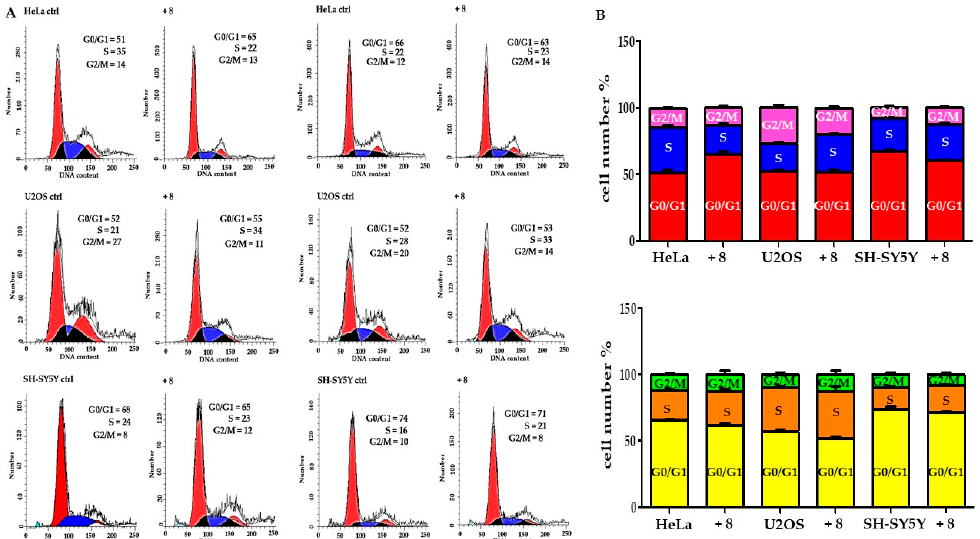
Figure 6. Cell cycle analysis. ( A ). Representative data showed cell cycle distribution with PI staining followed by flow cytometry analysis of HeLa, U2OS and SH-SY5Y cells treated whit 8 (5 μ M) for 24 (sx) or 48 h (dx). ( B ). Histograms show the G1, S and G2/M phase distribution of HeLa, U2OS and SH-SY5Y cells from three separate experimental analyzes, after 24 h (above) and 48 h (below) of treatment. Error bars based on the mean ± SD of three independent experiments.